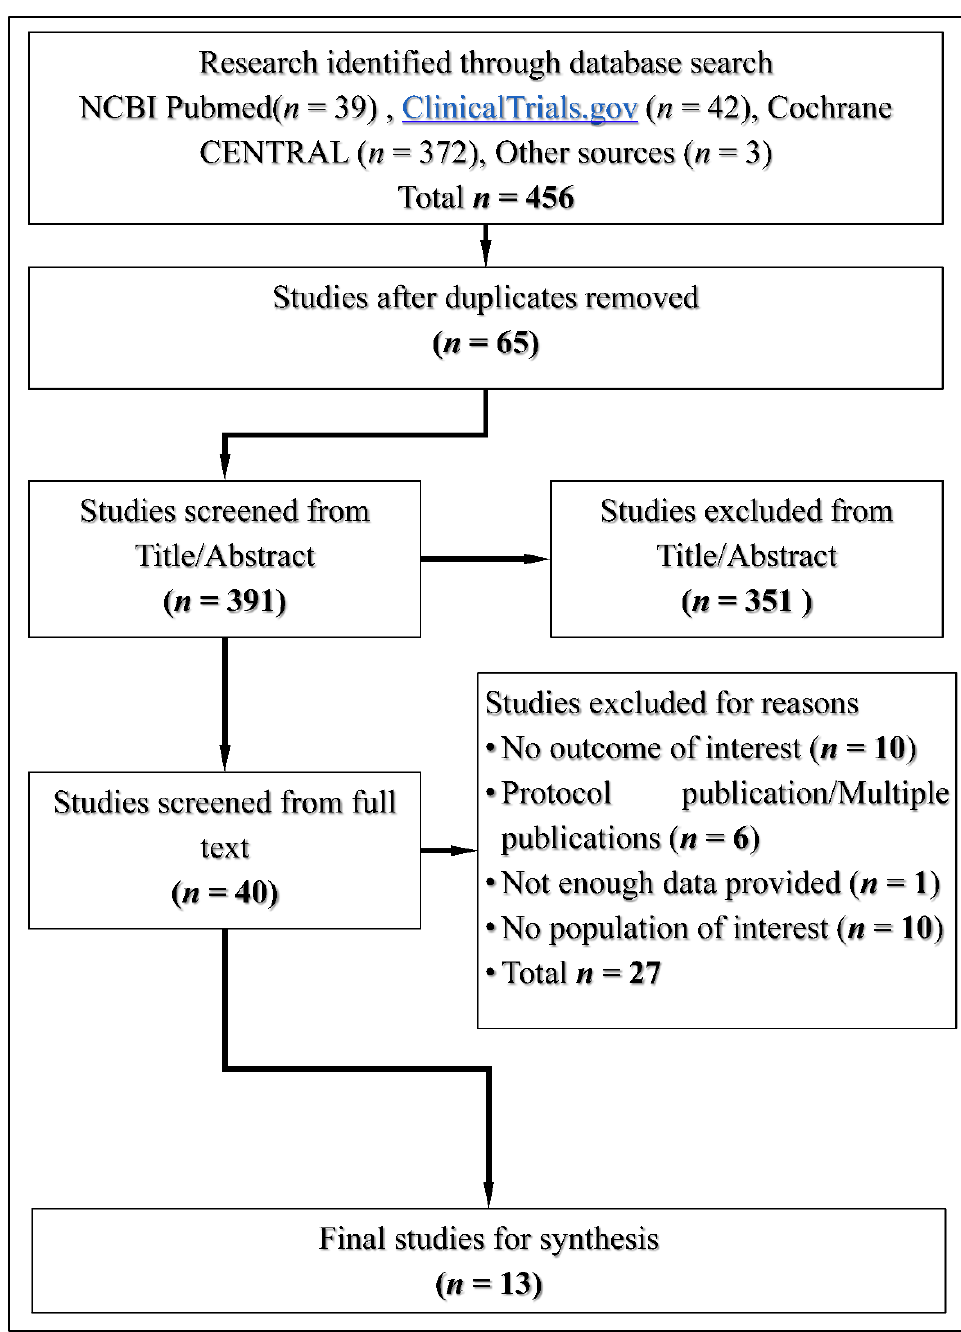
Figure 1. The flowchart of study selection.